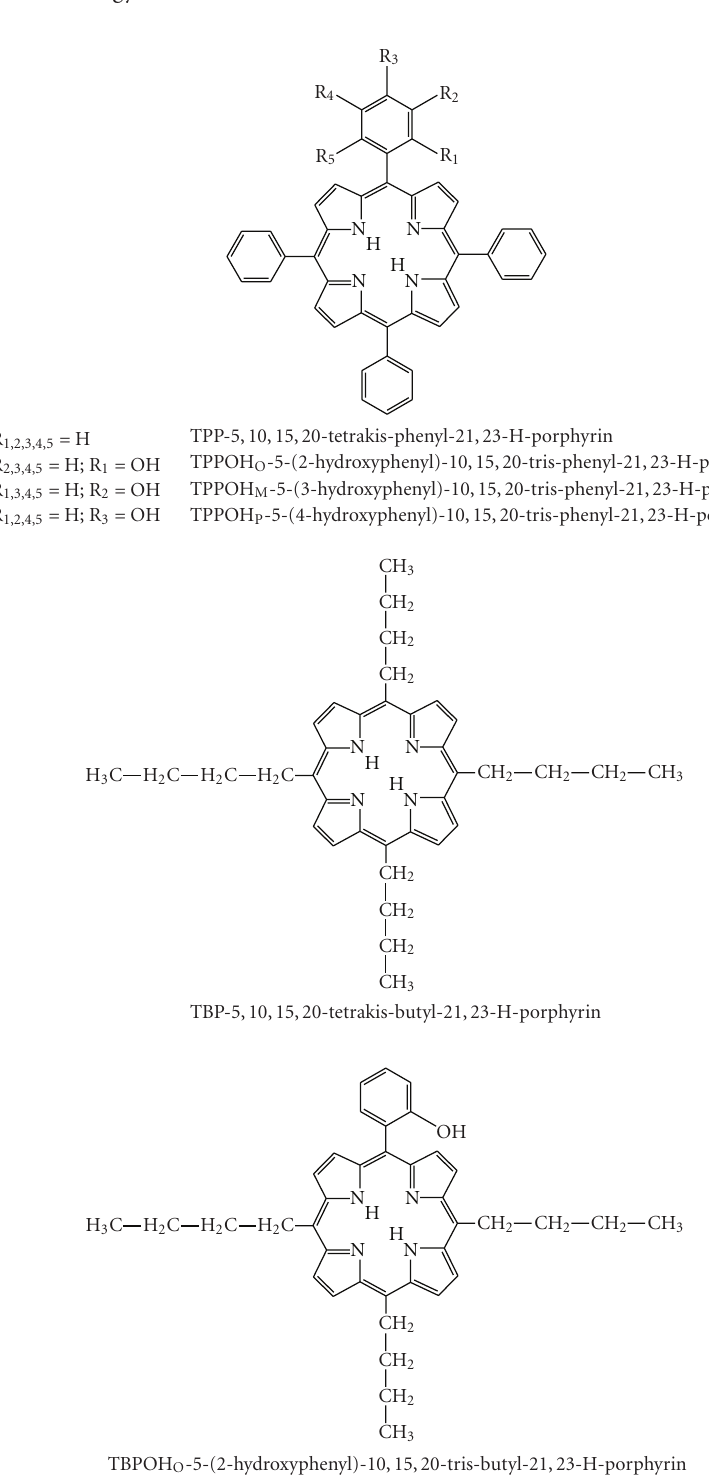
Scheme 1: Porphynin